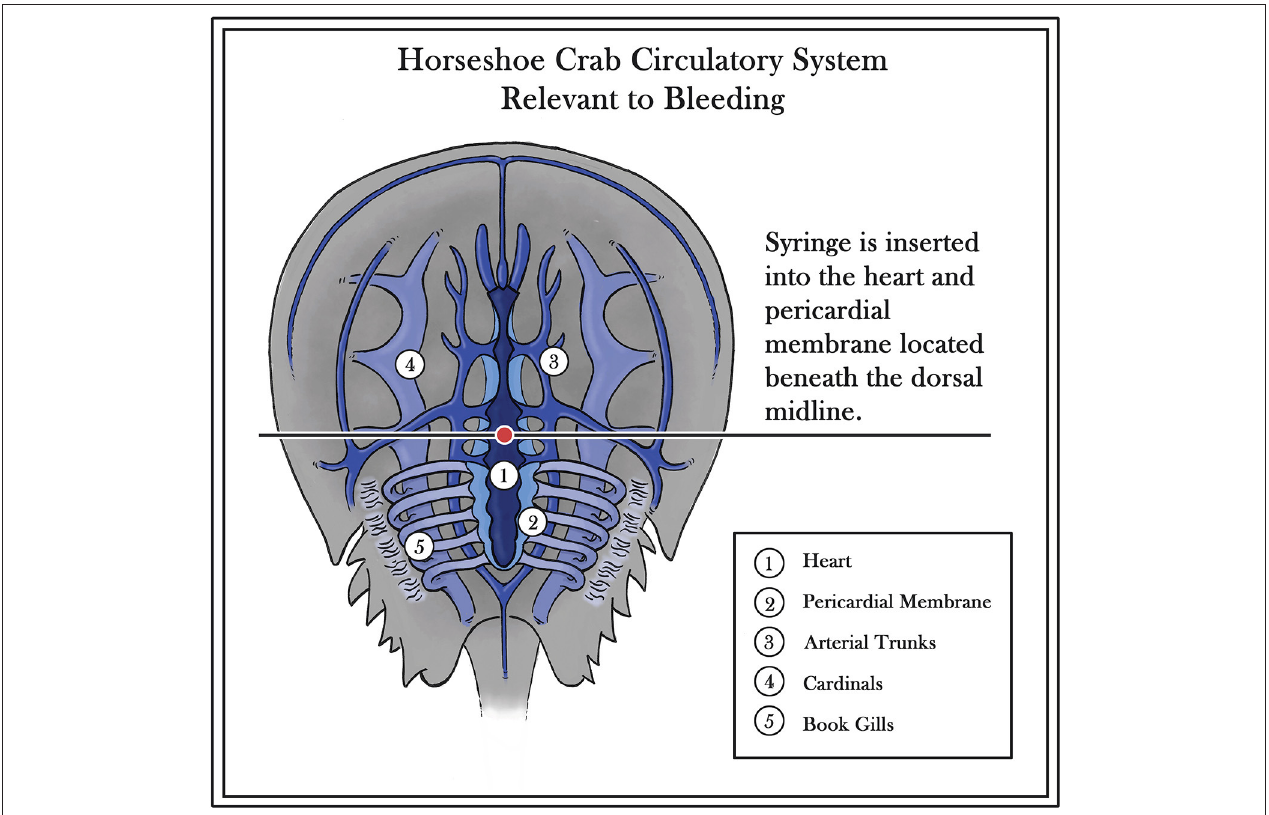
FIGURE 2 | Diagram of horseshoe crab circulatory system (Diagram modified from Patten, 1912; copyright permission, reuse or modifications of Figure 2 are not required for this image as it is in the Public Domain and holds no